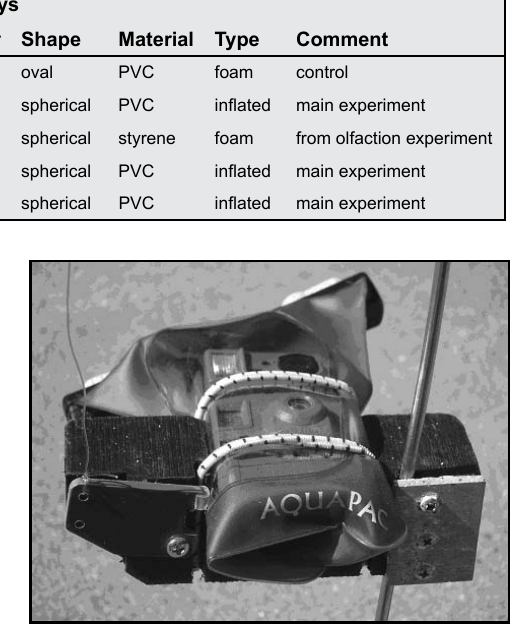
Fig. 4. Experimental set-up with disposable camera in waterproof bag and self-triggering arrangement.